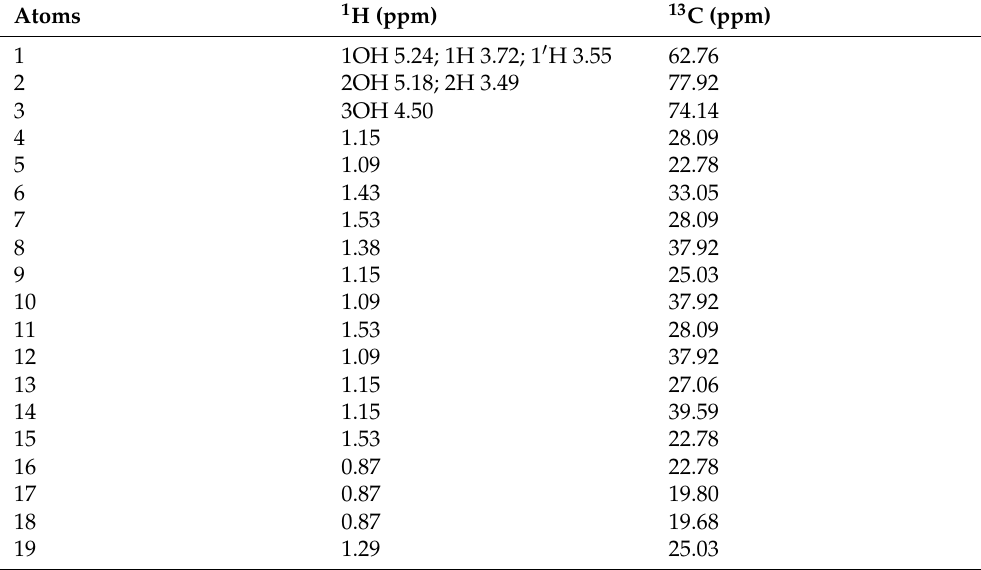
Table 1. 1 H and 13 C-{ 1 H} chemical shift attributions of PT22 at 298 k, day